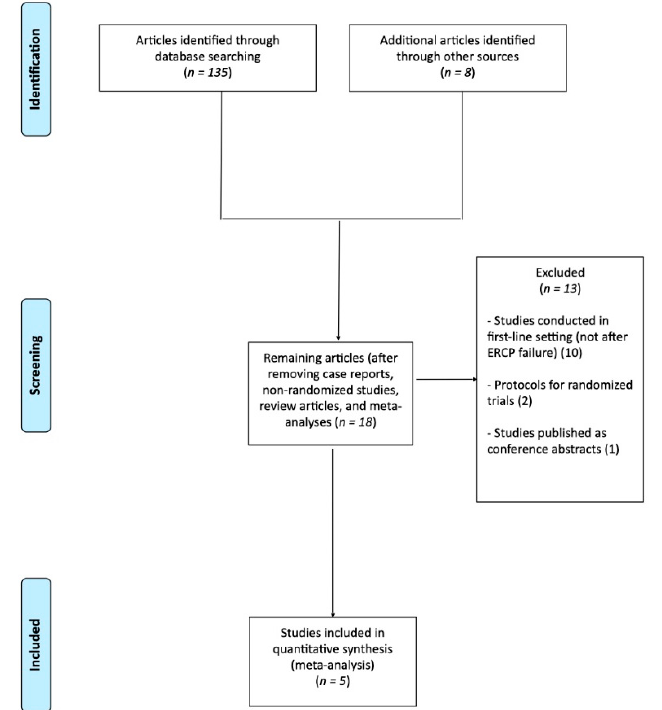
Figure 1. Flow chart of the included studies. Table 1. Baseline characteristics of the included trials.